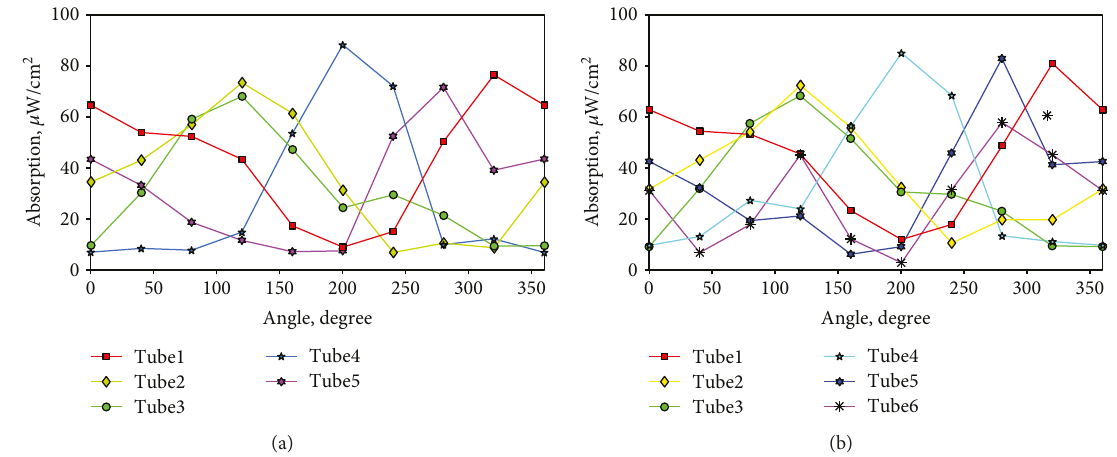
Figure 7: Power fl ux absorption distribution for the tubes in con fi gurations 2 (a) and 3 (b), for combined beam and di ff use irradiance. June 21st at 13:00 hours.